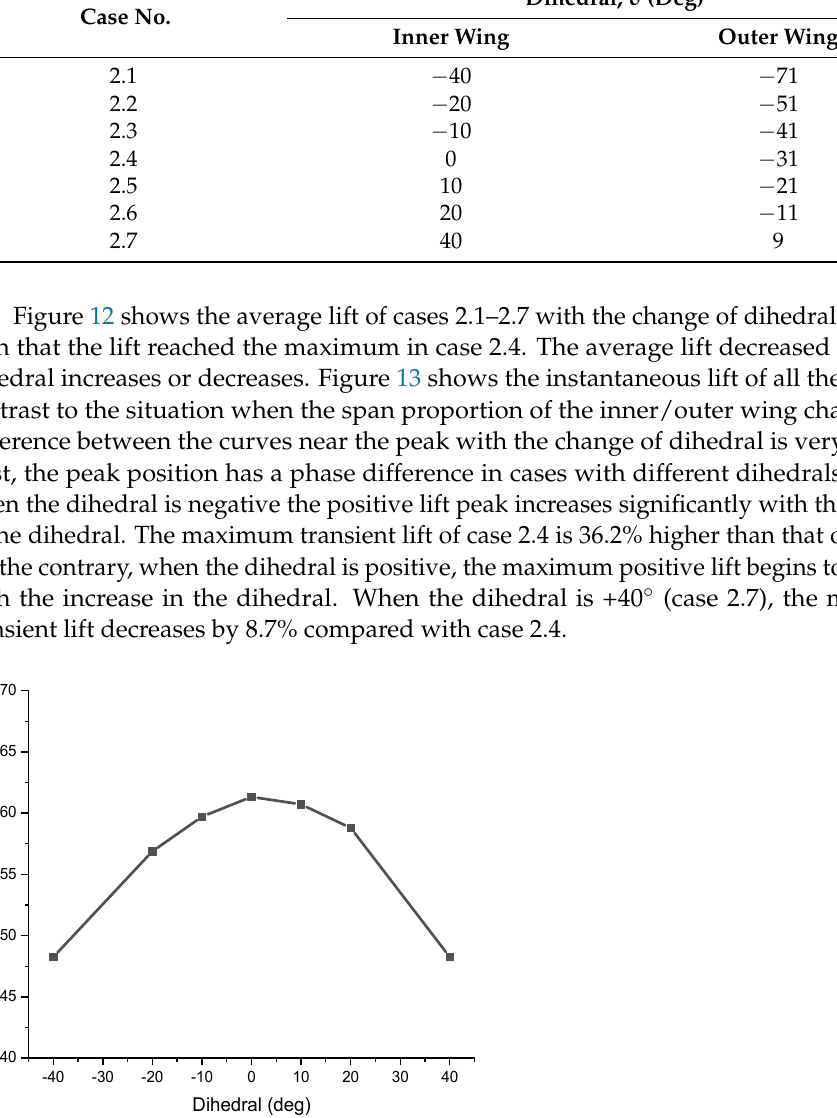
Table 4. List of cases for analysis of effect of dihedral. Case No.